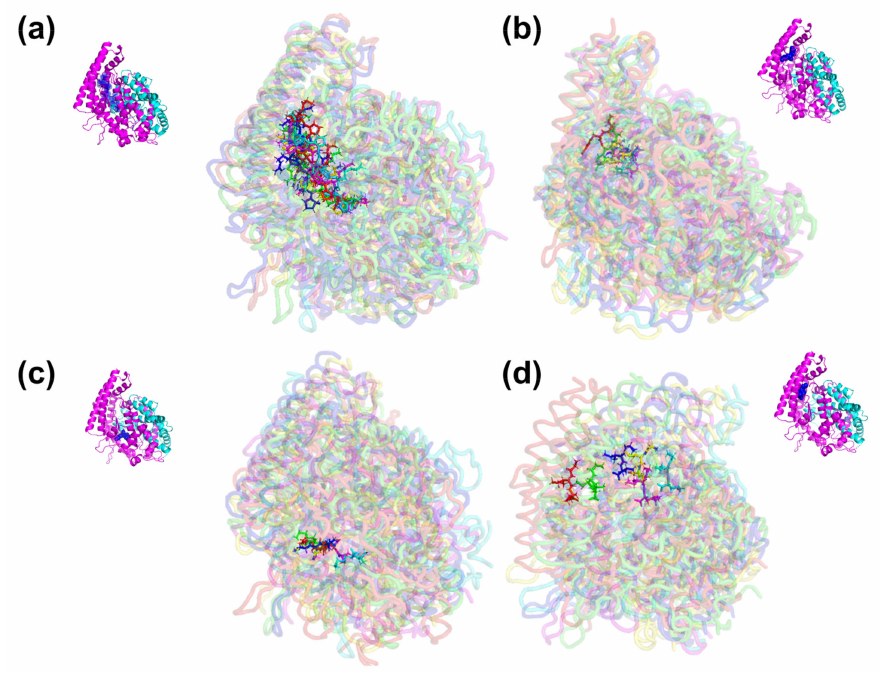
Figure 4. Snapshot of the superimposed structures of ACE in complex with peptide ( a ) BPPb, ( b ) VY, ( c ) AK and ( d ) GIL. Structures were obtained from the trajectory file in the interval of 5 ns for 25 ns